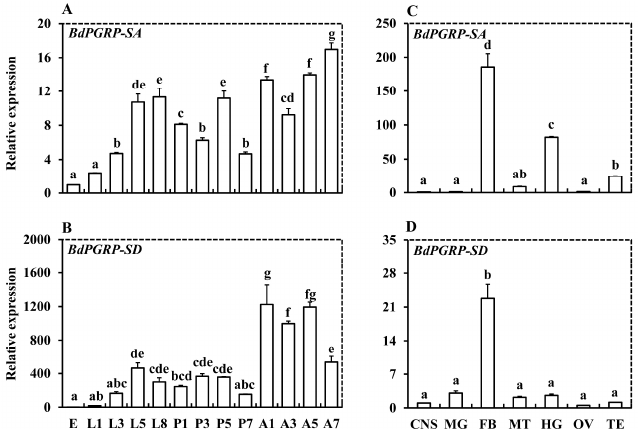
Figure 3. Gene expression profiles of BdPGRP-SA and BdPGRp-SD in the different developmental stages ( A and B ), and tissues of 5-day-old Bactrocera dorsalis adults ( C and D ). Egg (E); larvae on days 1, 3, 5, and 8 (L1, L3, L5, L8); pupae on days 1, 3, 5, and 7 (P1, P3, P5, P7); and adults on days 1, 3, 5, and 7 (A1, A3, A5, A7) of B. dorsalis were sampled for developmental stage expression analysis. Central nervous (CNS), midgut (MG), hindgut (HG), fat body (FB), Malpighian tubule (MT), ovary (OV), and testis (TE) in 5-day-old adults were collected for tissue expression determination. Different letters above the error bars indicate statistical differences ( p < 0.05).